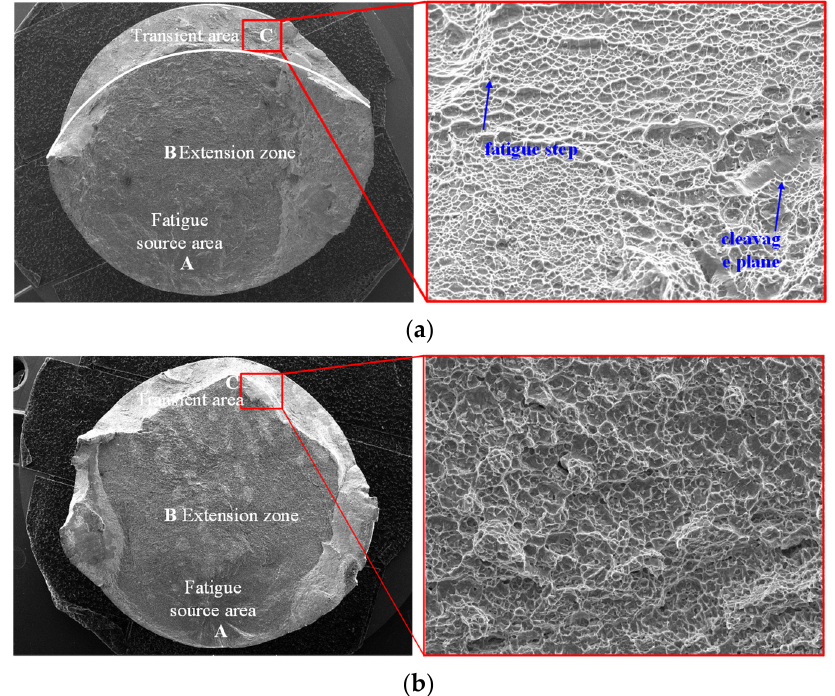
Figure 15. Fatigue transient area of turned and ultrasonic-impacted specimens. ( a ) Turned specimen; ( b ) Ultrasonic-impacted specimen.